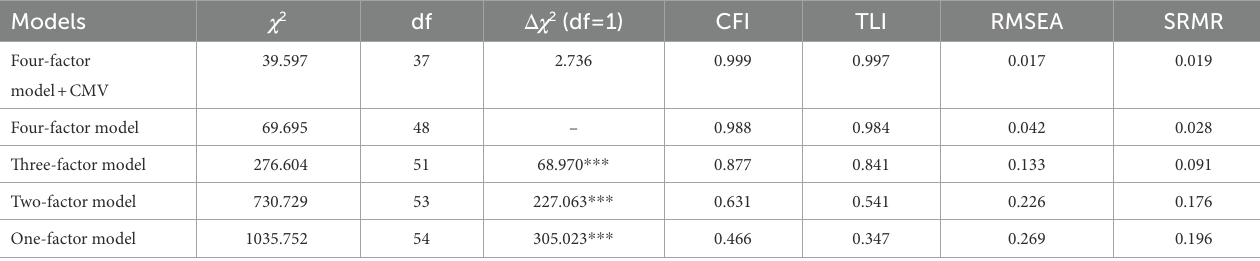
TABLE 2 Results of confirmatory factor analysis ( N = 251).